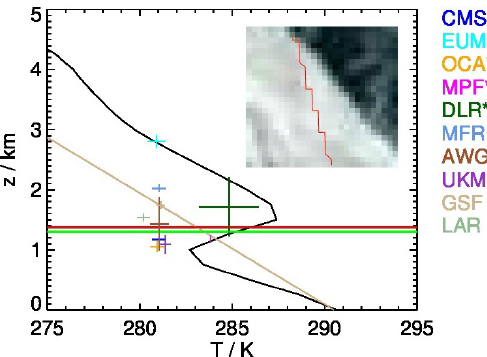
Figure 13. Cloud top height vs. temperature for the homogeneous marine stratocumulus region. The crosses mark the results of the different SEVIRI algorithms. The length of the lines mark the stan- dard deviation of these properties. The chosen track is illustrated as RGB in the upper right corner. The green and red line mark the cloud top height of CALIOP and CPR, respectively. The black line shows the temperature profile as provided by the ECMWF- AUX product. Groups that did not submit a cloud top height, but a cloud top pressure (that we converted to cloud top height using ECMWF data) are marked with a star *. The temperature profile constructed with a climatological temperature gradient used by the GSF retrieval is shown as brown